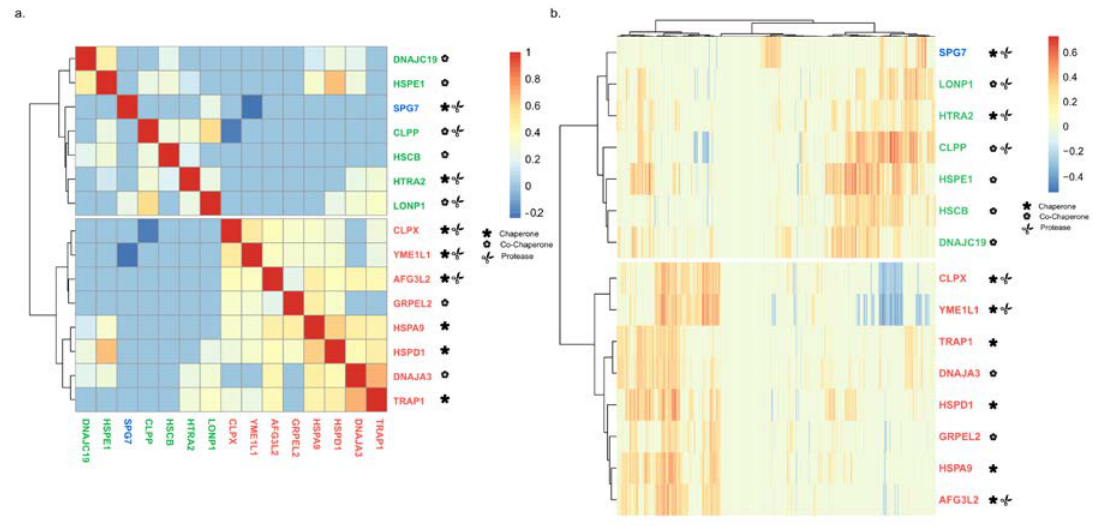
Figure 4. Major clustering groups similar to the generated modules. ( a ) Hierarchical clustering of chaperone–chaperone interactions. ( b ) Hierarchical clustering of chaperone–client interactions. r-values are color-coded. Chaperones are color-coded according to their module.